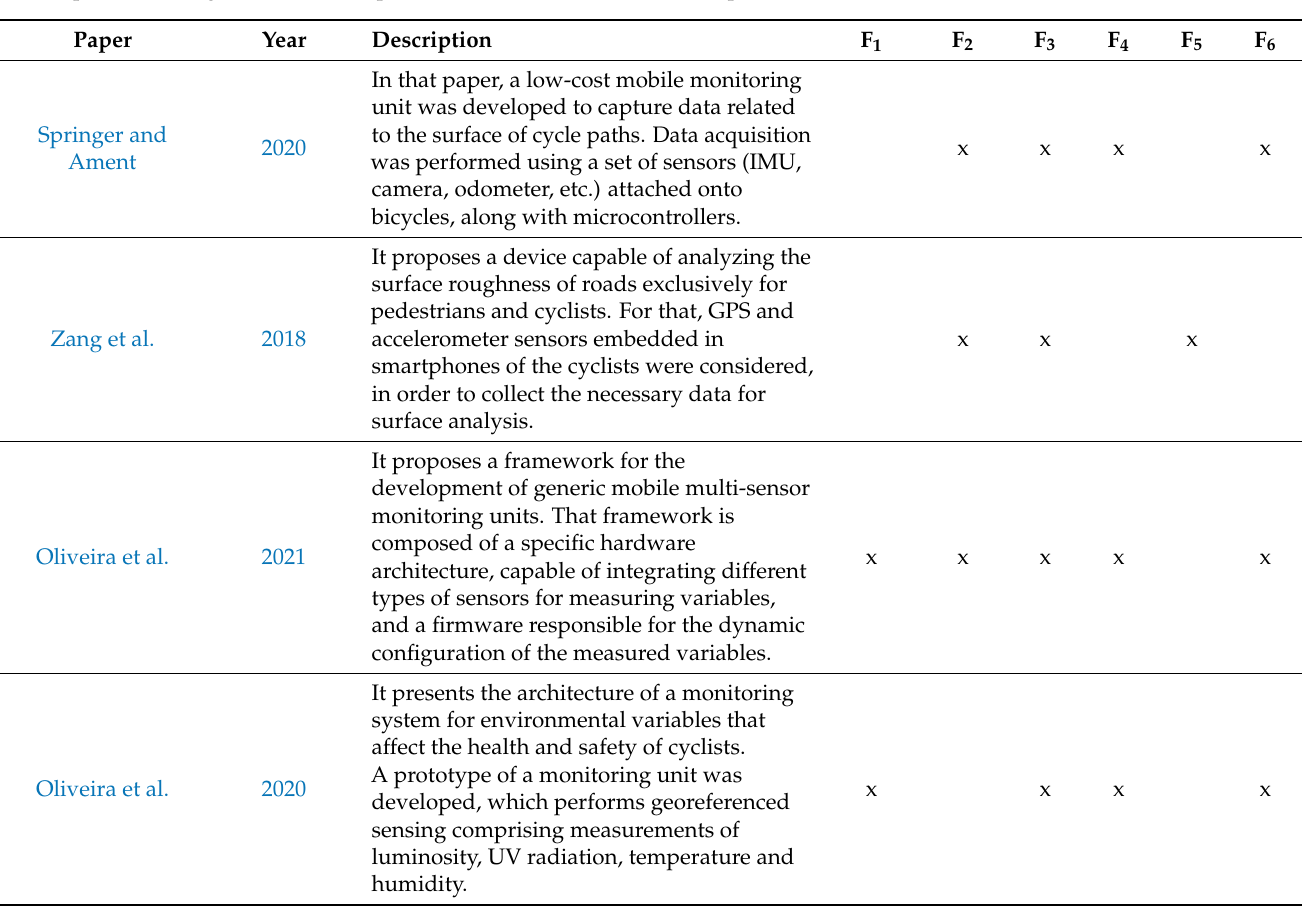
Table 1. Works focused on the monitoring of cycle paths conditions exploiting sensors attached onto bicycles. Sensing approach features: F 1 —environmental sensing, F 2 —infrastructure sensing, F 3 —multi-sensors solution, F 4 —development of a specific sensing unit, F 5 —smartphone-based solution, F 6 —offline